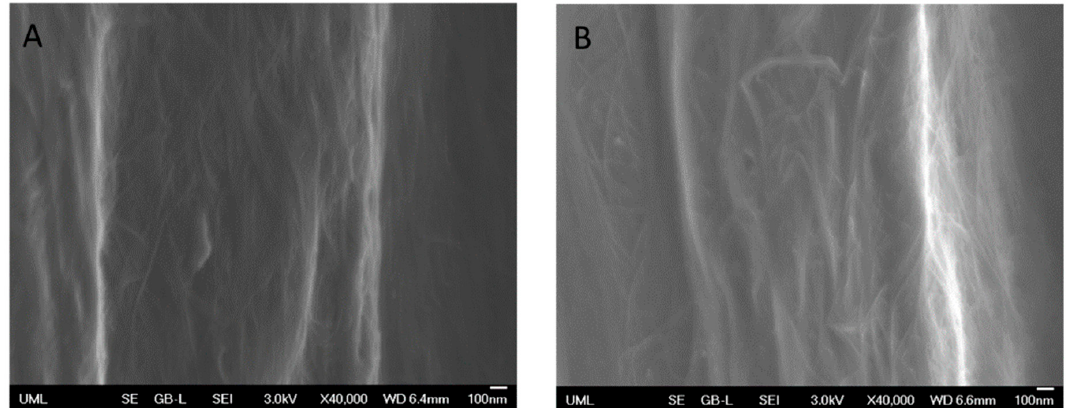
Figure 4. Post treated CNTY (side view) before stretching ( A ) and after uniaxial stretching to 5% strain ( B ).